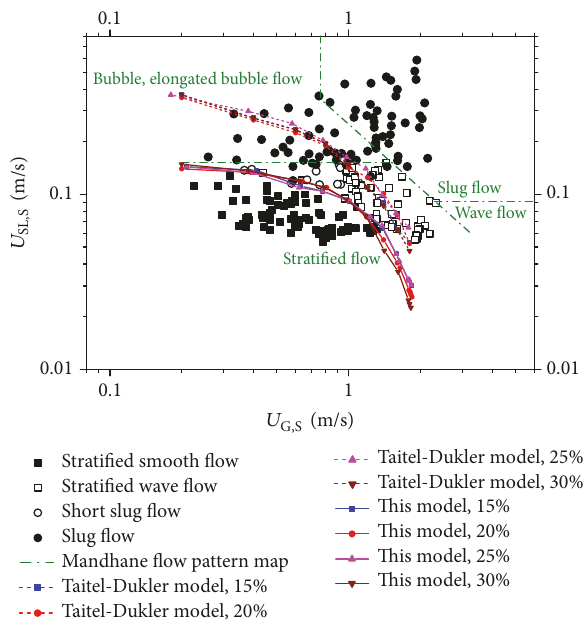
Figure 8: Flow pattern distribution for gas-slurry stratified flow at different water cuts.